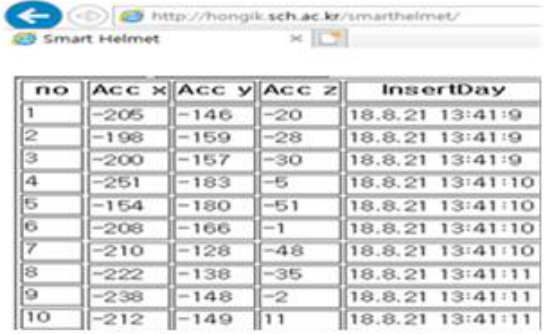
Figure 5. On-site PC web platform for storing data (Acc X, Y,